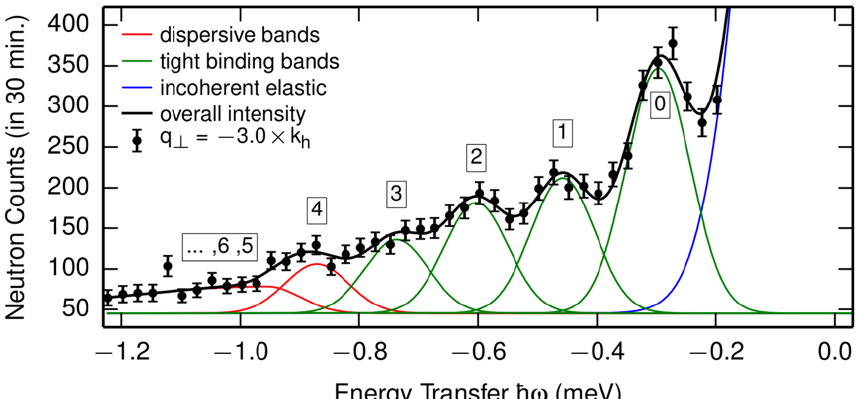
Figure 2. The figure (reproduced from [27], c (cid:13) by the American Physical Society, USA) shows an energy scan measured at T = 20 K and for a fixed reduced momentum transfer q perpendicular to the wave vector k h of the helix. Five bands are readily resolved and can be parametrized using a multi-Gaussian spectrum. The elastic peak appears due to incoherent